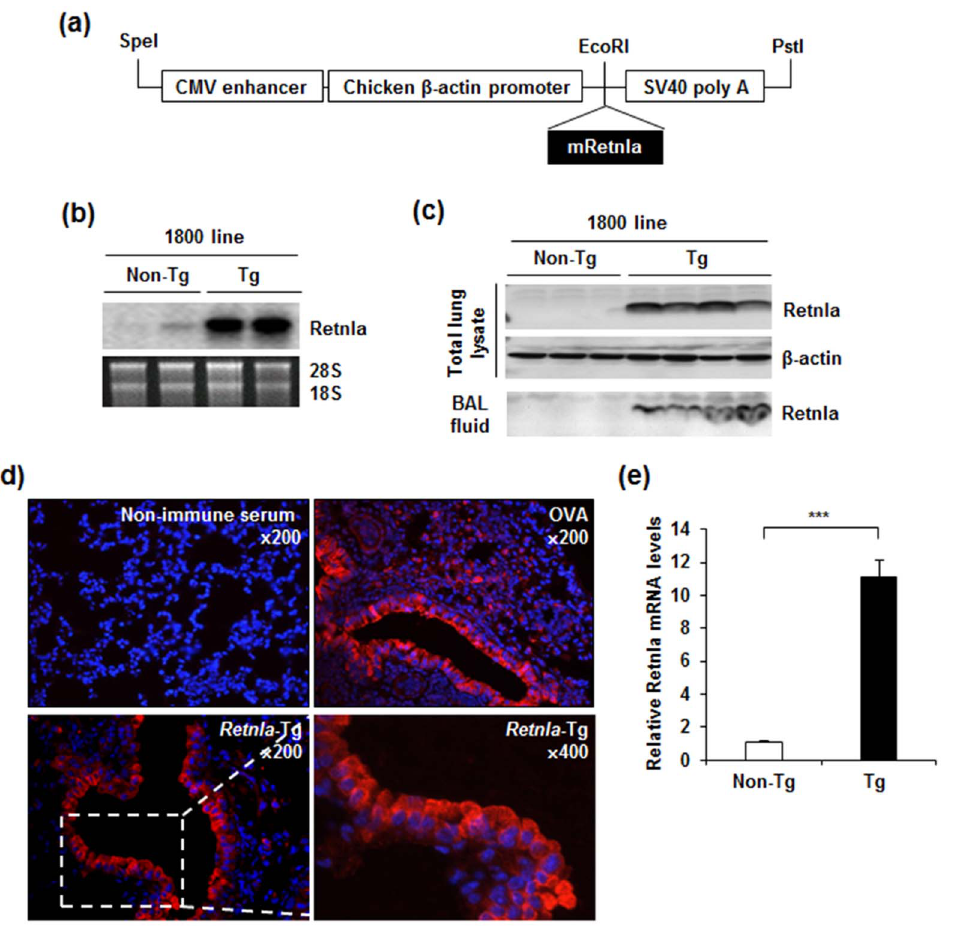
Figure 1. Generation of Retnla- Tg mice, and the expression pattern of Retnla in lung. (a) DNA construct for generating Retnla- Tg mice. Mouse Retnla cDNA was cloned into the EcoR I site of the pCAGGS vector. The transgene was excised as a Spe I and Pst I fragment for microinjection. (b) Northern blot analysis of total RNA extracted from lungs of Retnla- Tg and non-Tg mice. 28S and 18S rRNA were used as controls for RNA amount and integrity. (c) Immunoblot analysis of mouse Retnla from lung and bronchoalveolar lavage (BAL) fluid of Retnla- Tg and non-Tg mice. b -actin was also analyzed as a loading control. (d) Control staining using non-immunized rabbit serum. Representative Retnla staining in lungs of OVA sensitized/challenged mice (upper right) and Retnla- Tg mice (bottom row). Nuclei were stained with DAPI (blue). Inset: original magnification, 200 6 . (e) Quantitative RT-PCR analysis showing mRNA expression of Retnla in peritoneal macrophages of non-Tg and Retnla -Tg mice (n 5 5 per group). Data are represented as mean ¡ SD. Mann-Whitney U-test; ***P ,